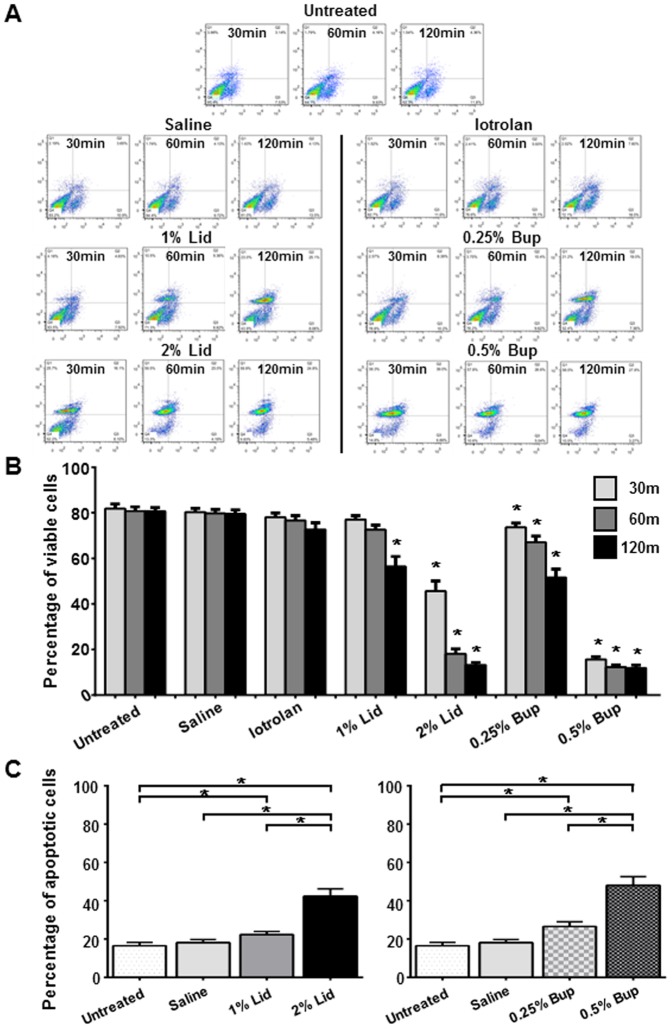
Flow cytometric analysis of human nucleus pulposus (NP) cells.NP cell–alginate 3D composites were exposed to saline, radiocontrast agent (iotrolan), or local anesthetic agents (lidocaine and bupivacaine) for 30, 60, or 120 min, cultured 24 h, then the NP cells were isolated for analysis. (A) Flow cytometry scatter plots. (B) Time- and dose-dependent effects on cell viability (*, p<0.05 vs. untreated control and saline at the same exposure time). (C) Dose-dependent effects on cell apoptosis after 60 min (*, p<0.05). Data are from five independent experiments (mean ± SE). Bup, bupivacaine; Lid, lidocaine.